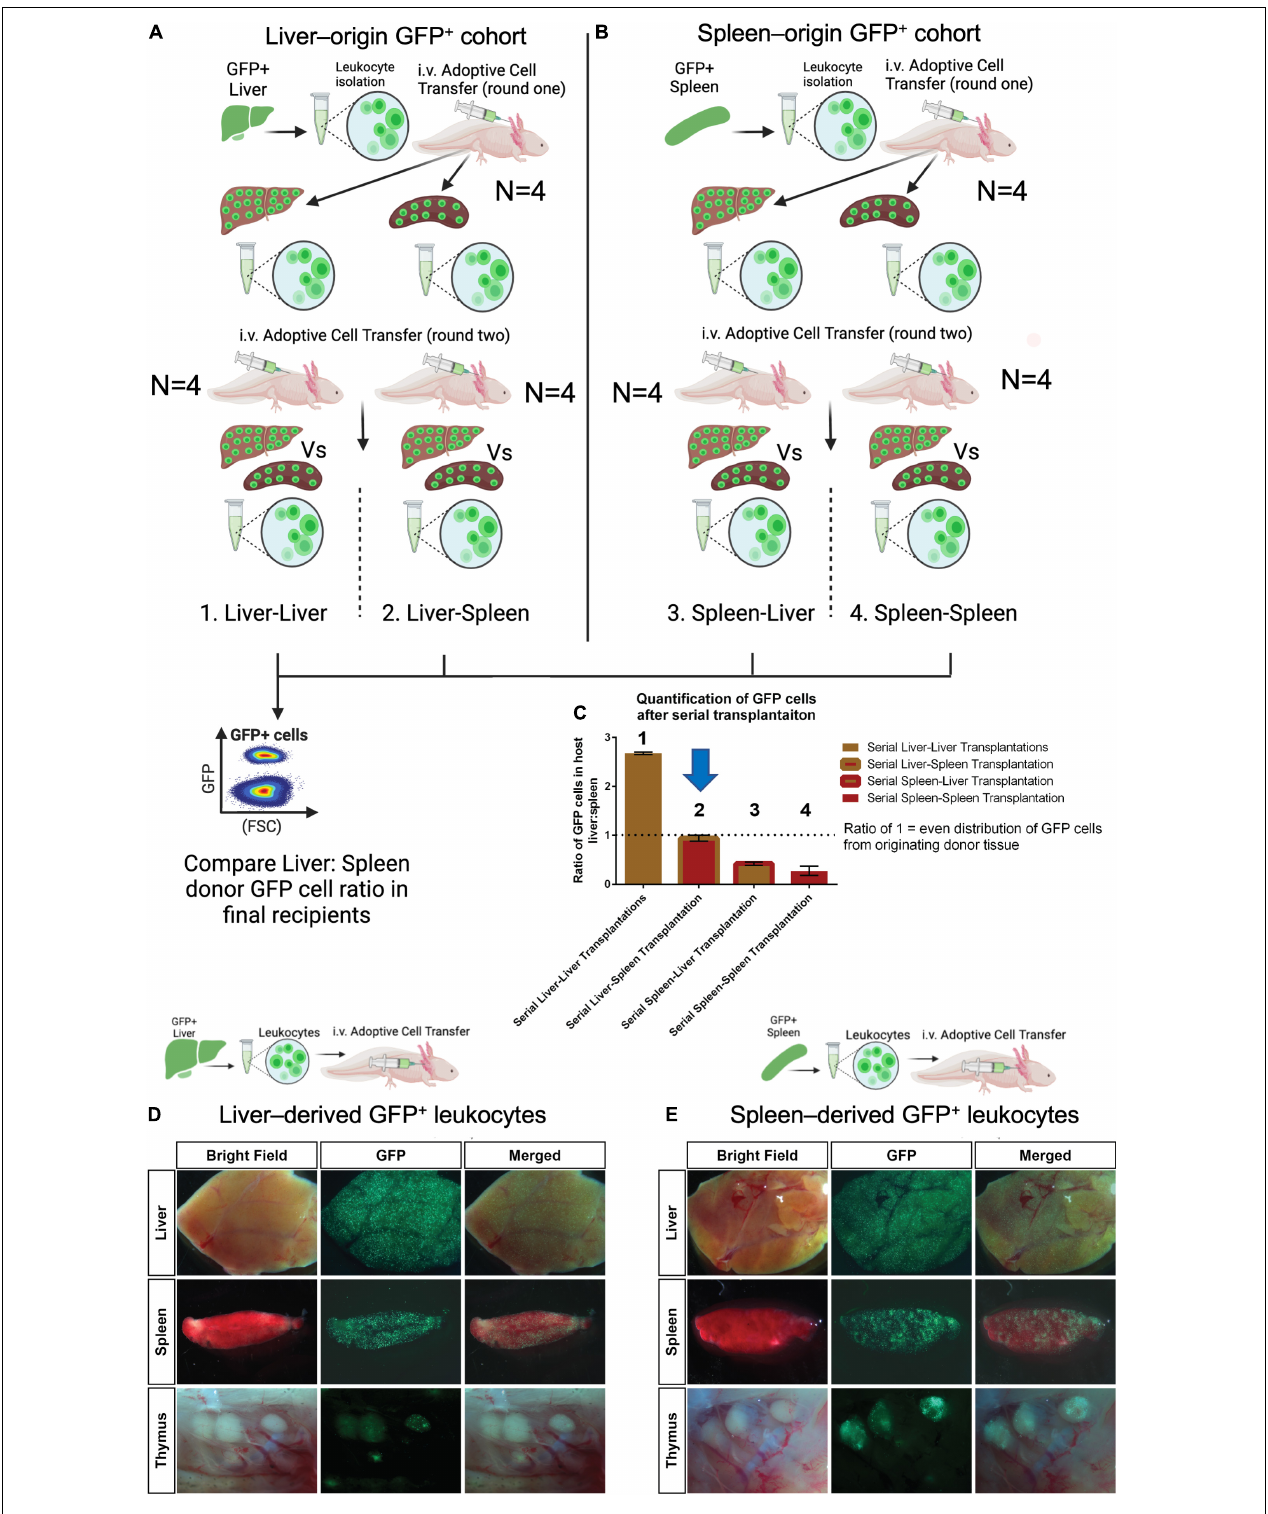
FIGURE 6 | GFP + cell homing in serial transplants reveals preference for organ of origin that is lost in liver-derived cells that have been educated in the spleen. (A) Experimental strategy displayed as a cartoon depicting serial liver and spleen transplantation to quantify GFP cell homing bias. Liver-derived GFP + cells from four individual animals were adoptively transferred into four separate non-GFP hosts (round one transfer). Seven days post transfer GFP + cells were collected from livers